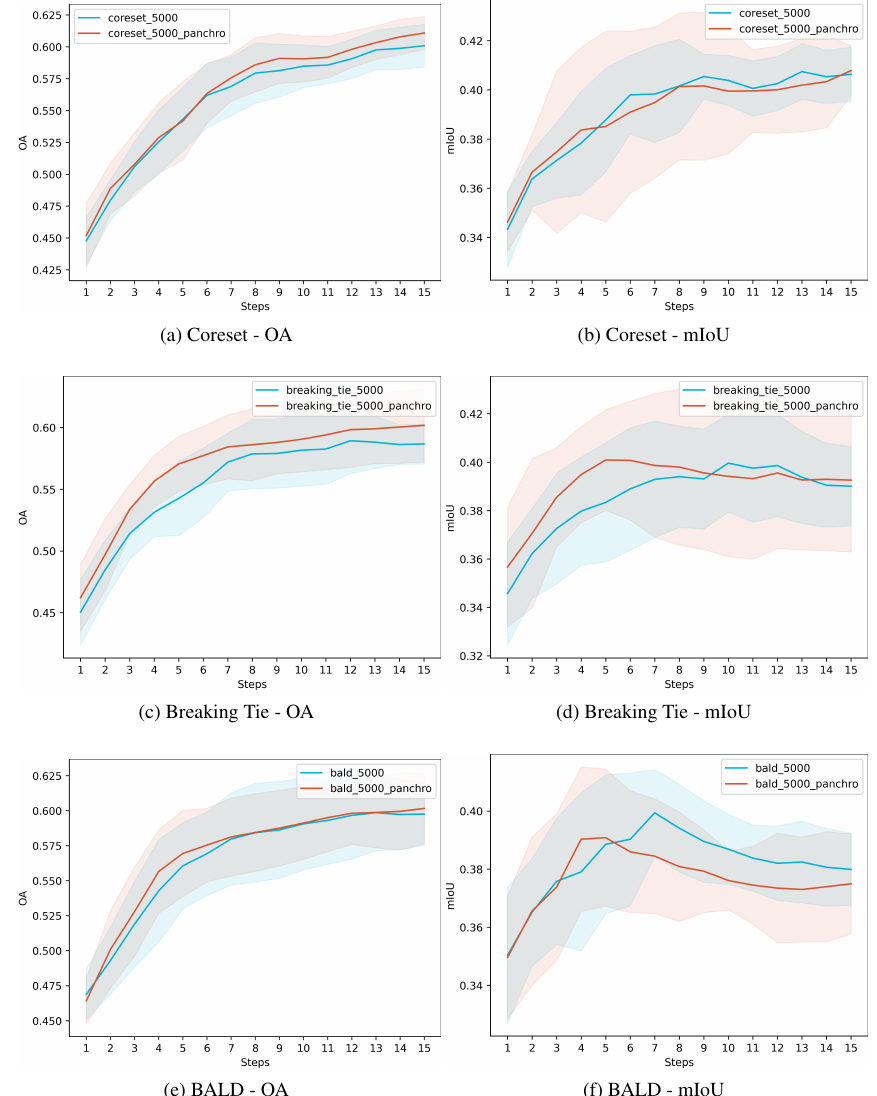
Figure 9. Accuracy metrics with a 5000-regions segmentation. Red curves correspond to the ”panchromatic” segmentation” while the blue curves correspond to the ”PCA”